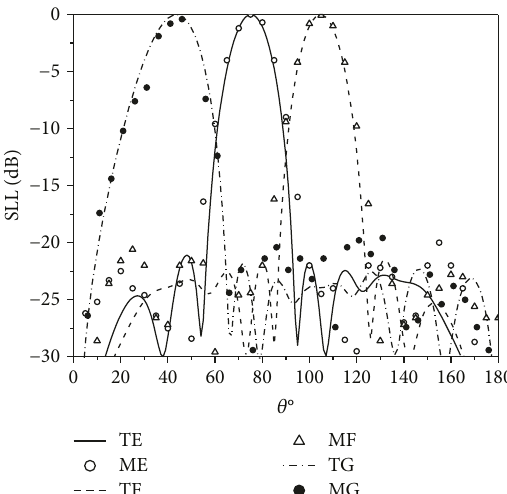
Figure 14: Normalized radiation patterns at 1.9 GHz of the 8-element antenna array fed by the 8 × 8 BM, according to the schemes shown in the last 3 rows of Table 4. The curves TE, TF, and TG depict the theoretical results that correspond to beams E, F, and G, respectively. Accordingly, ME, MF, and MG stand for the